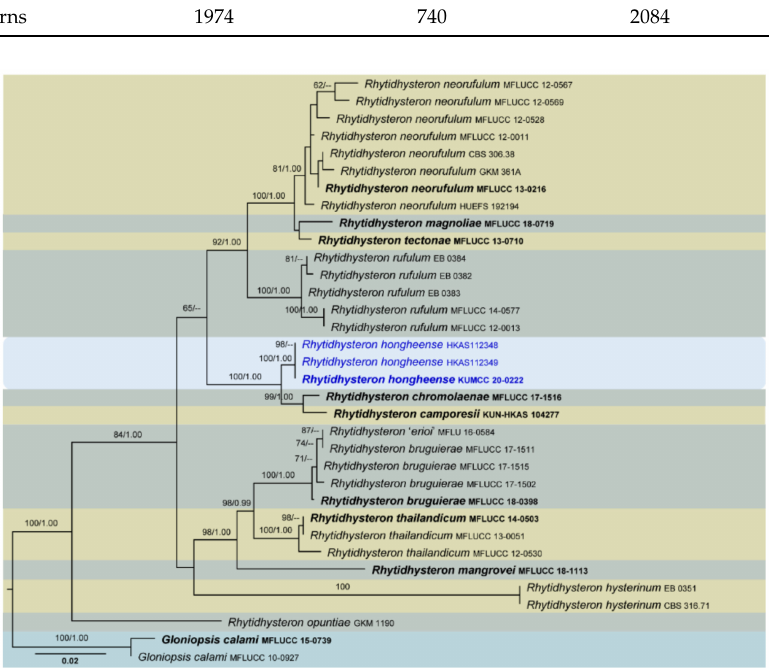
Figure 2. RAxML tree based on a combined dataset of partial SSU, LSU, ITS and tef 1 DNA sequence analysis in Rhytidhysteron . The tree is rooted to Gloniopsis calami (MFLUCC 15-0739, MFLUCC 10- 0927). Bootstrap support values for ML equal to or greater than 60% and BYPP equal to or greater than 0.95 are shown as ML/BI above the nodes. Known species are indicated with coloured blocks. Blue represents new isolates. The ex-type strains are indicated in bold . The scale bar represents the expected number of nucleotide substitutions per